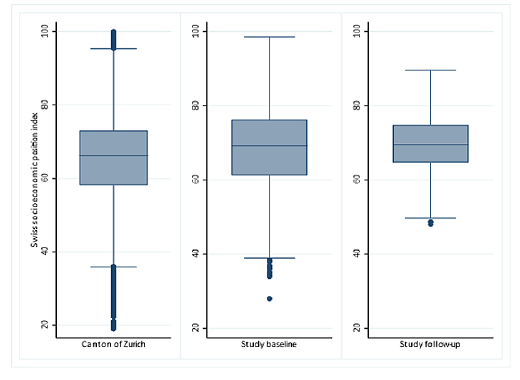
Figure 4: Box plots showing the distribution of Swiss socioeco- nomic position index (Swiss-SEP) for families with at least one child aged 6–17 years and living in the canton of Zurich and in the LuftiBus in the School (LUIS) study at baseline and follow-up. The median is represented by a horizontal line inside the box, 25 and 75 percentiles by the upper and lower box horizontal lines of the box, minimum and maximum values are shown as whiskers, and points outside the whiskers are outliers.